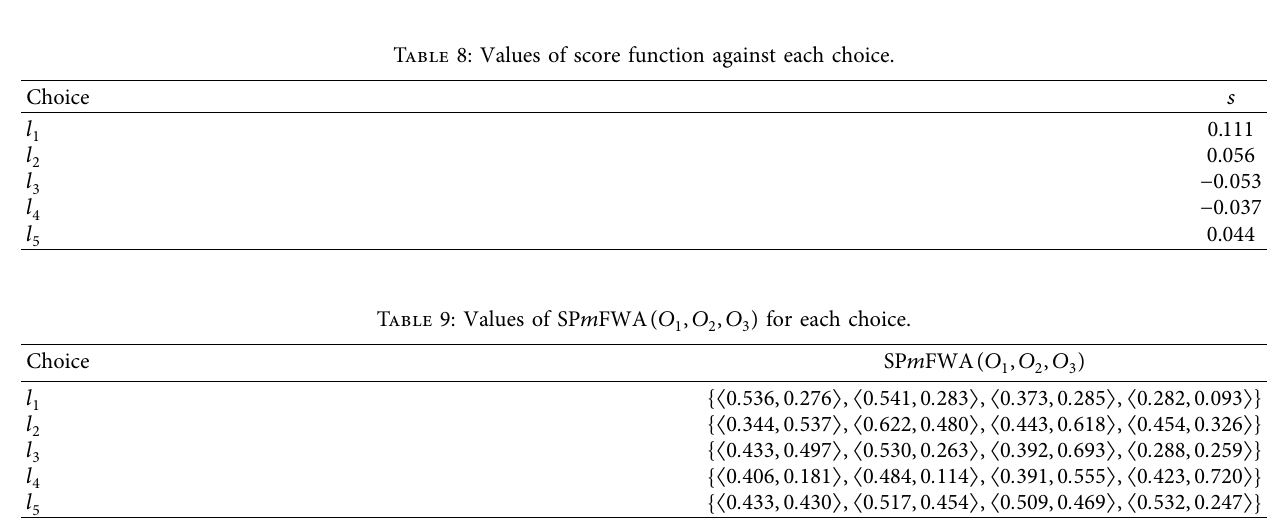
Table 8: Values of score function against each choice.